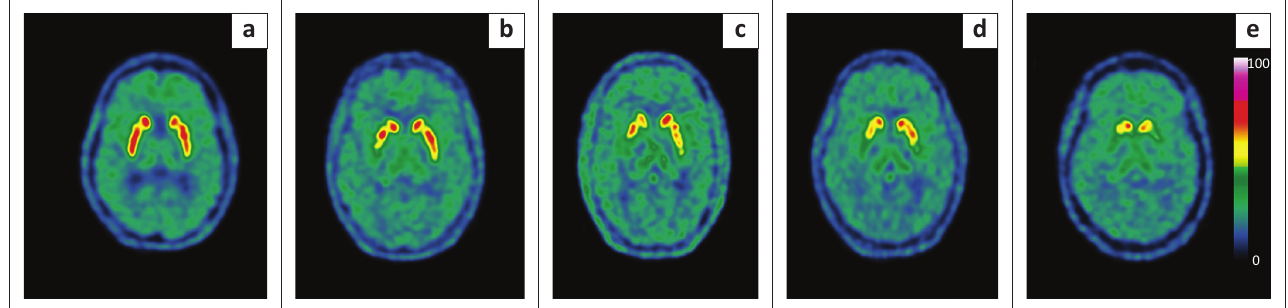
FIGURE 3: Fluorine-18 FDOPA PET scans in five patients with movement disorders demonstrating absence of dopaminergic deficit (a) in a patient with essential tremor, and progressive stages of dopaminergic deficit (b – e) in patients with neurodegenerative disorders of the striatum.